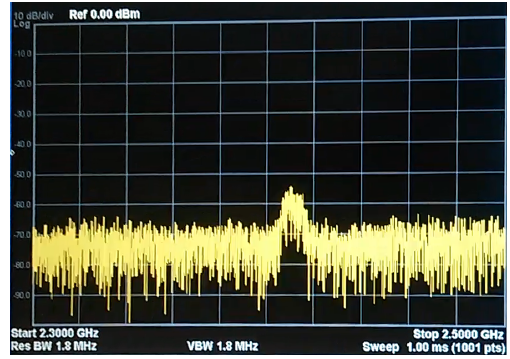
Figure 4. Radio spectrum between 2.3 GHz and 2.5 GHz at the transmission time of a Waspmote.